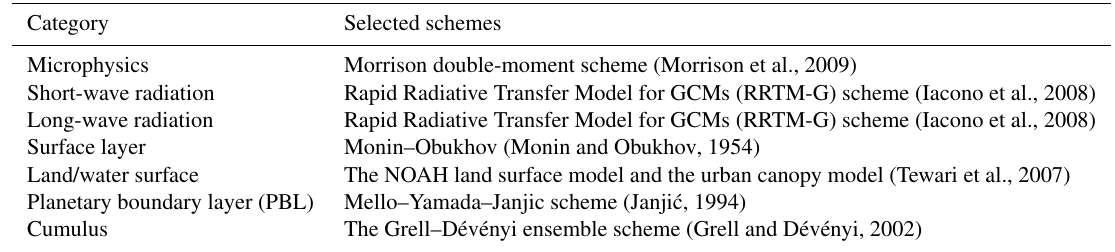
Table 2. Physics parameterizations used in the Weather Research and Forecasting (WRF) model setup.